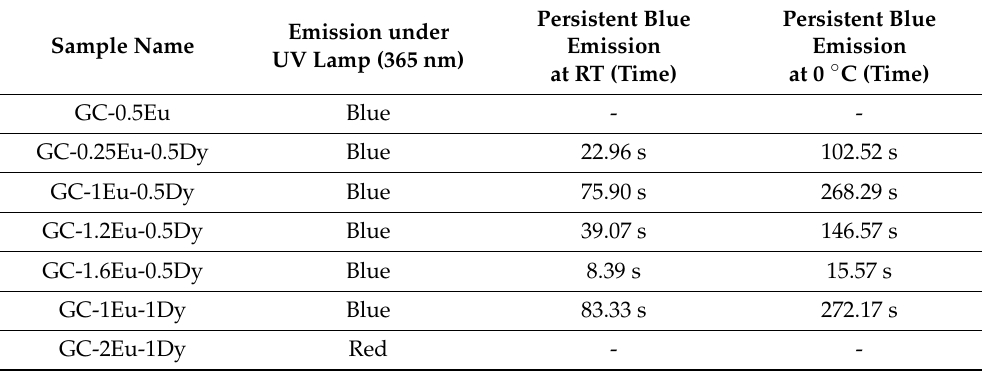
Table 1. Glass-ceramics nomenclature and persistent blue emission information. Measurements were repeated 3–4 times with an error of about 3